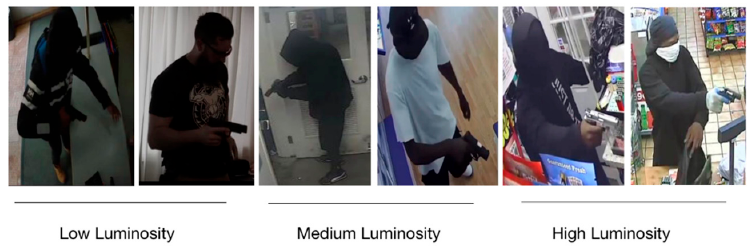
Figure 4. Luminosity scale.